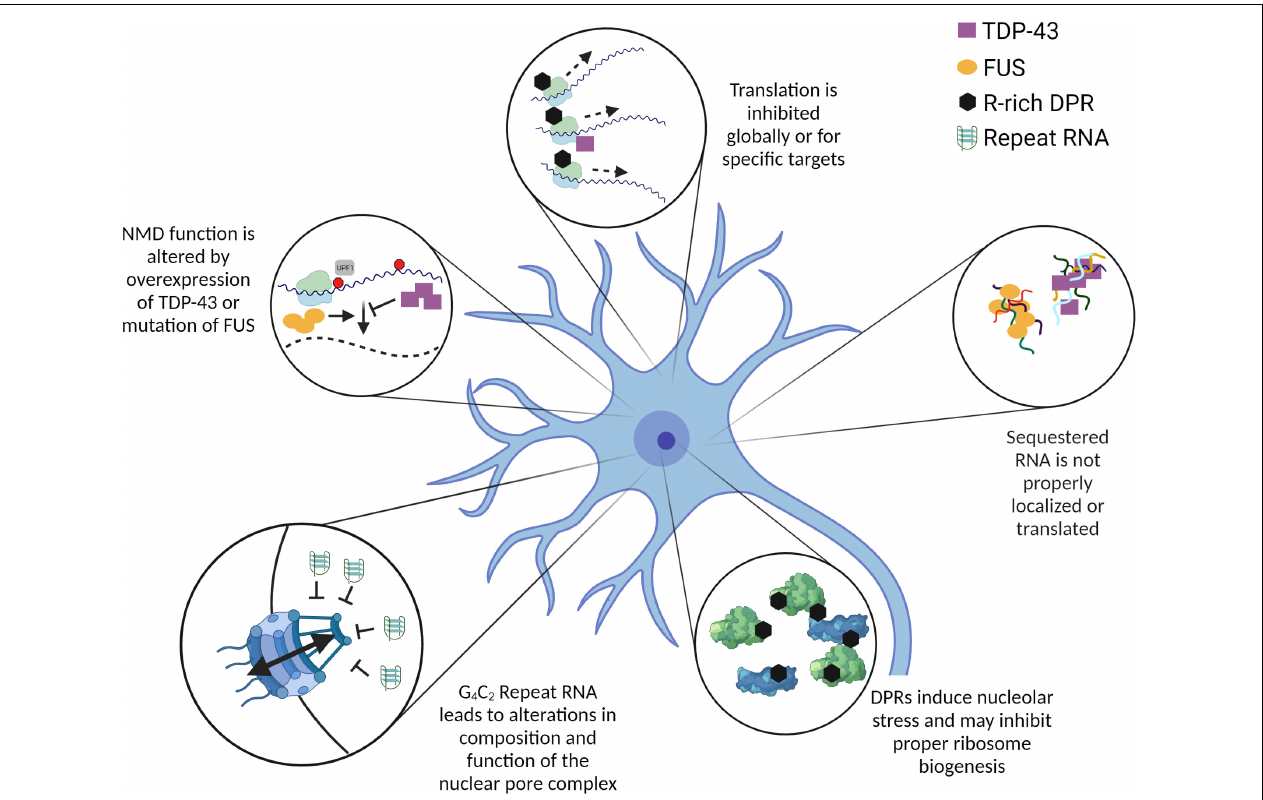
FIGURE 1 | Mutations and overexpression of ALS-related proteins and RNA contribute to altered RNA metabolism. The pathways and processes depicted here are altered by the overexpression or mutation of ALS-related genes. While the mechanisms leading to these alterations are not all fully characterized, it is evident that many RNA metabolic pathways are dysregulated in the context of ALS. In some cases, such as C9ALS, RNA itself can have a significant impact on cellular homeostasis. Further investigation into the mechanistic links between these altered processes will be crucial to understand the initiating event(s) in ALS pathogenesis. Created with